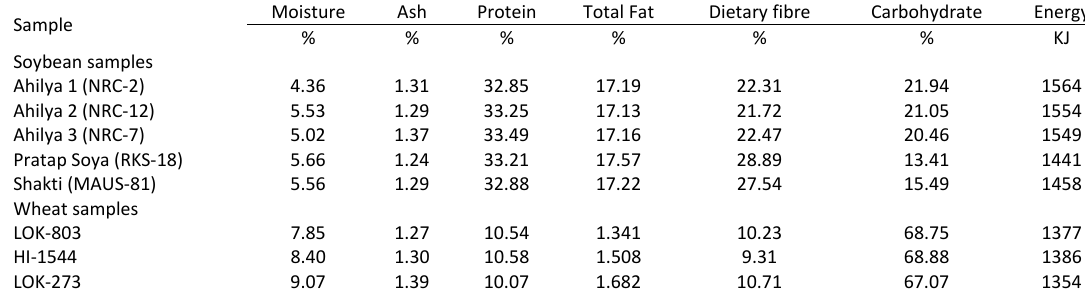
Table 2: Proximate values of analysed soybean and wheat cultivars Moisture Ash Dietary fibre Sample